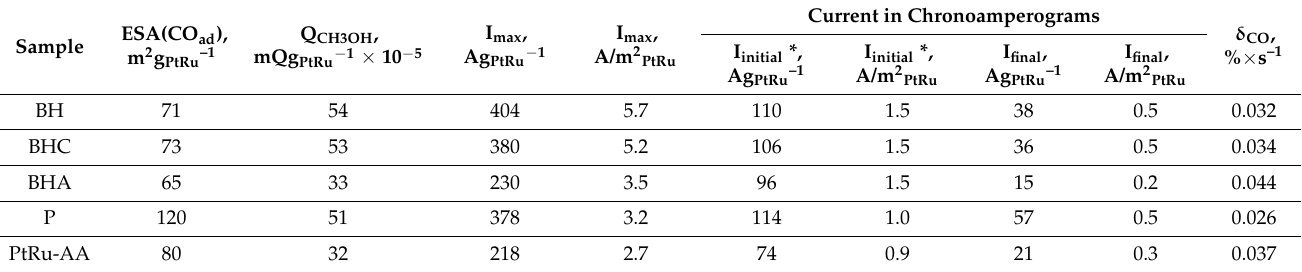
Table 2. The parameters characterizing the electrochemical behavior of the catalysts in the MOR.